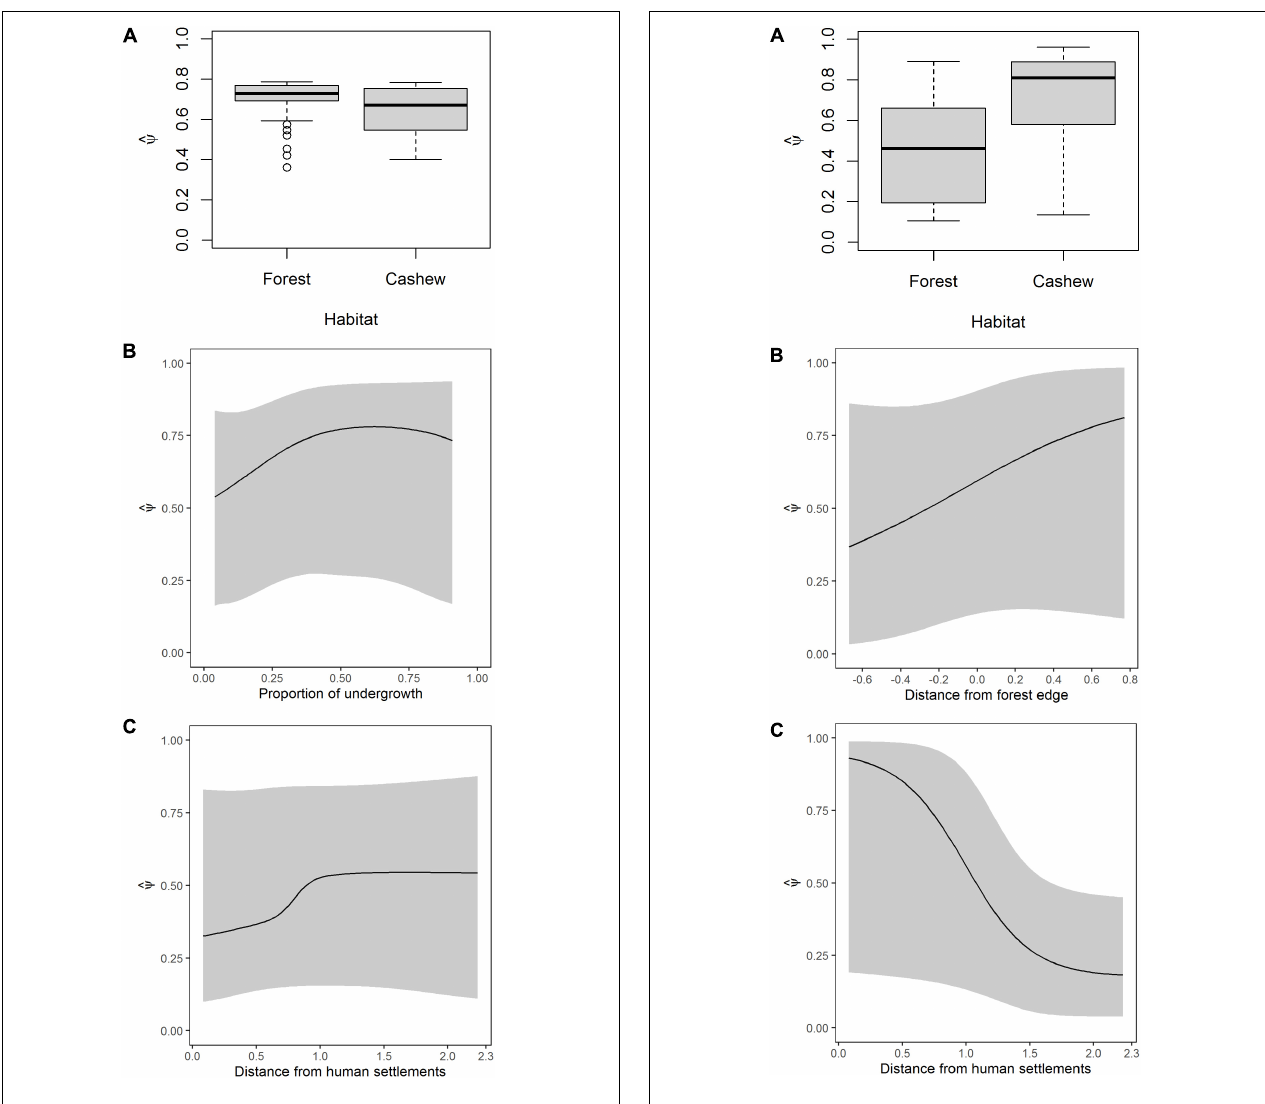
FIGURE 3 | Model-averaged estimates of habitat use of sambar as a function of (A) habitat type, (B) proportion of undergrowth, and (C) distance to nearest human settlement.